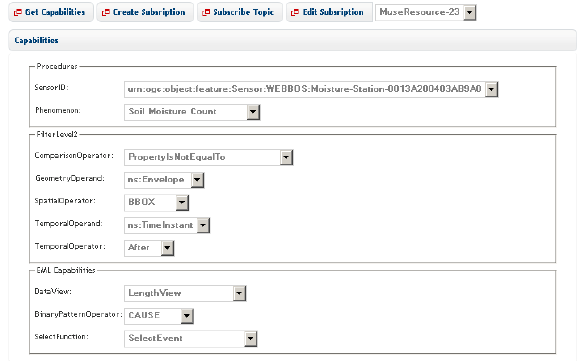
Figure 6. Web client using “MapBender”.